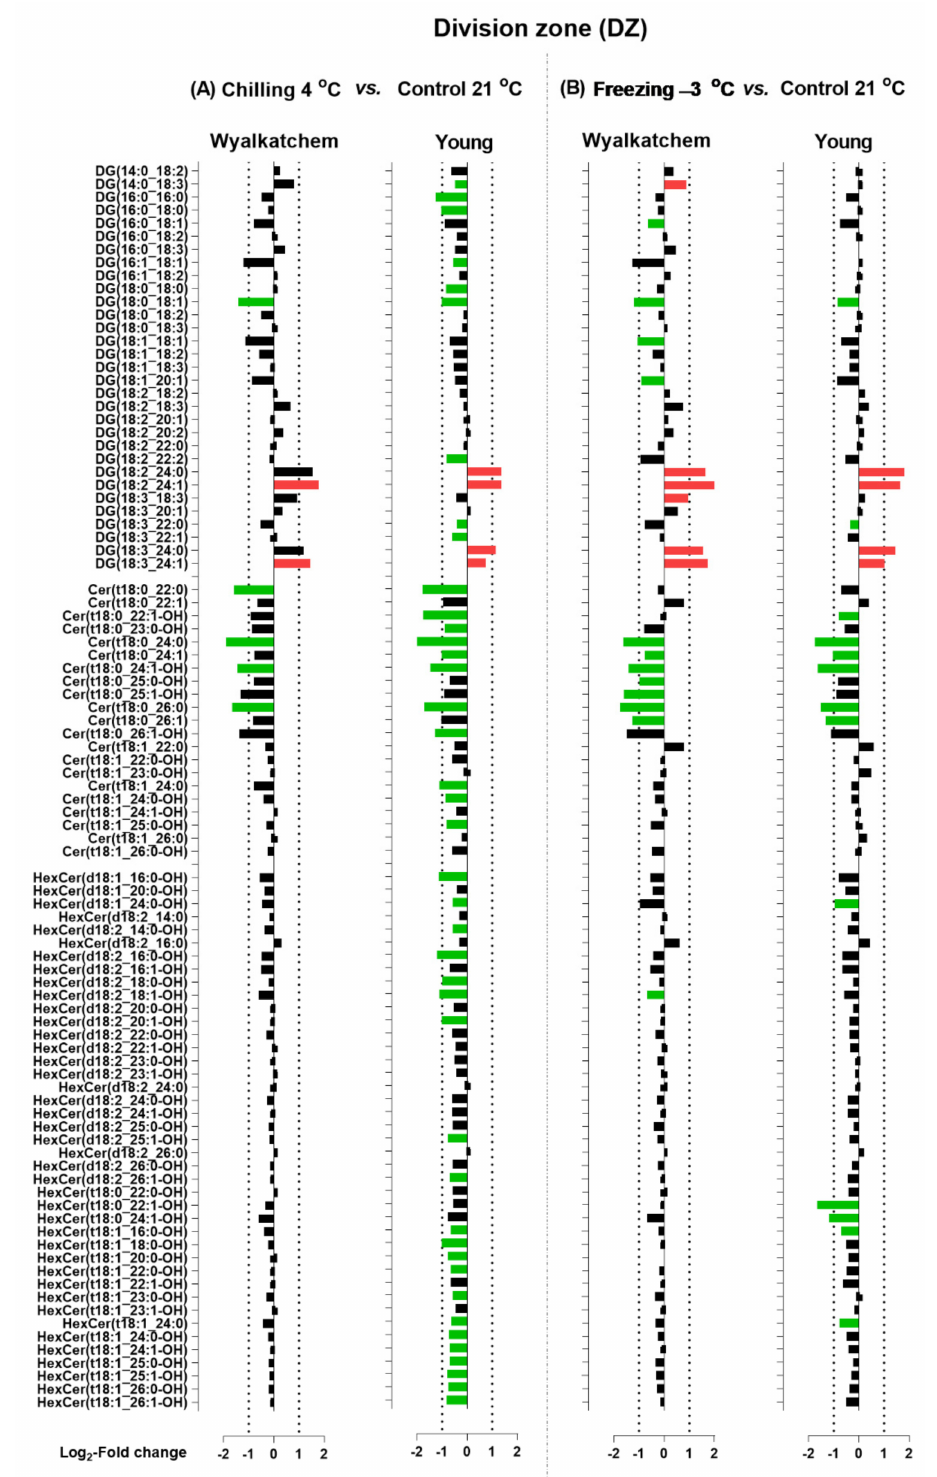
Figure 5. Log 2 -fold changes of DG, Cer, and HexCer species in the division zone (DZ) of cold- sensitive Wyalkatchem and cold-tolerant Young after exposure to ( A ) chilling and ( B ) freezing stress. Statistical significance was determined using an FDR-adjusted p -value of 0.05 as the cut-off. Green bar = significant decrease; Red bar = significant increase. Black bar represents lipid species that has no significant change after cold stress as compared to control. n =